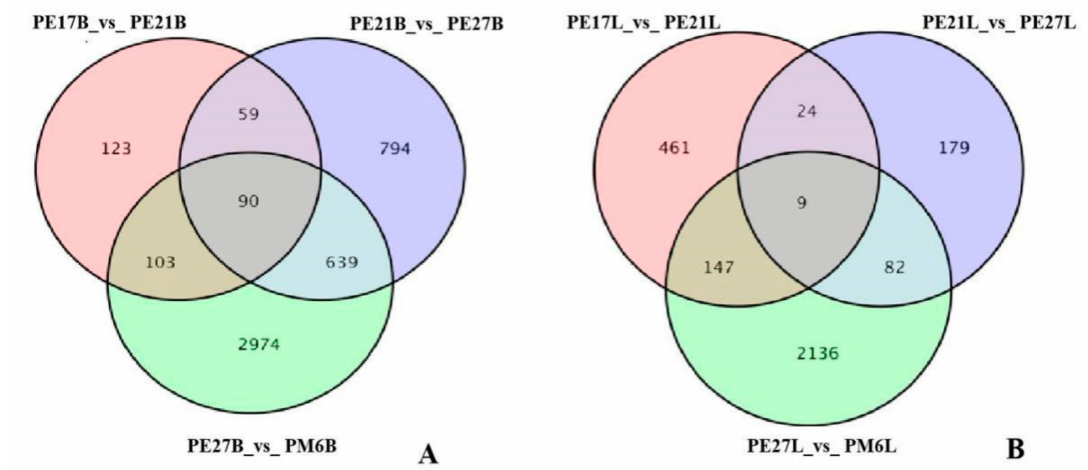
Figure 4. Venn diagram of differentially expressed genes among the three comparison groups. ( A ) The co-expressed DEGs in breast muscle of Pekin duck; ( B ) the co-expressed DEGs in leg muscle of Pekin